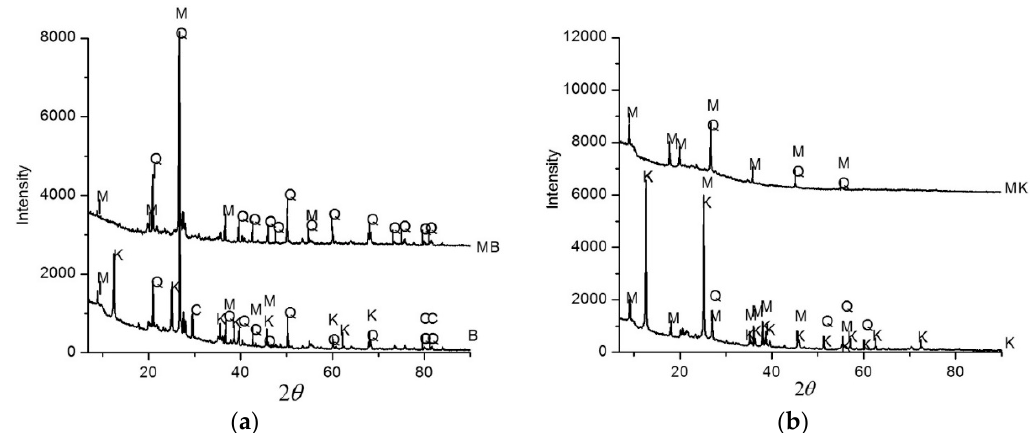
Figure 4. XRD patterns for ( a ) Sludge and ( b ) kaolin; M = mullite, K = kaolinite, Q = quartz, and C= calcite